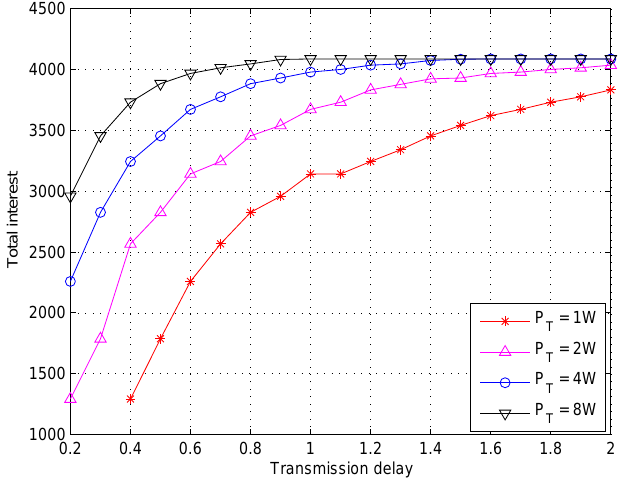
Figure 9. The total user interest as a function of the transmission delay with varying power constraint P T ( λ = 0.5 and ξ = 0.9).